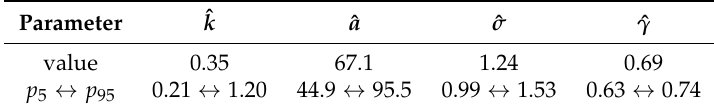
Table 1. Table detailing the estimated CKLS (Chan, Karolyi, Longstaff, and Sanders) parameters, as well as the limits of 90% covering interval sandwiched between the 5% and 95%